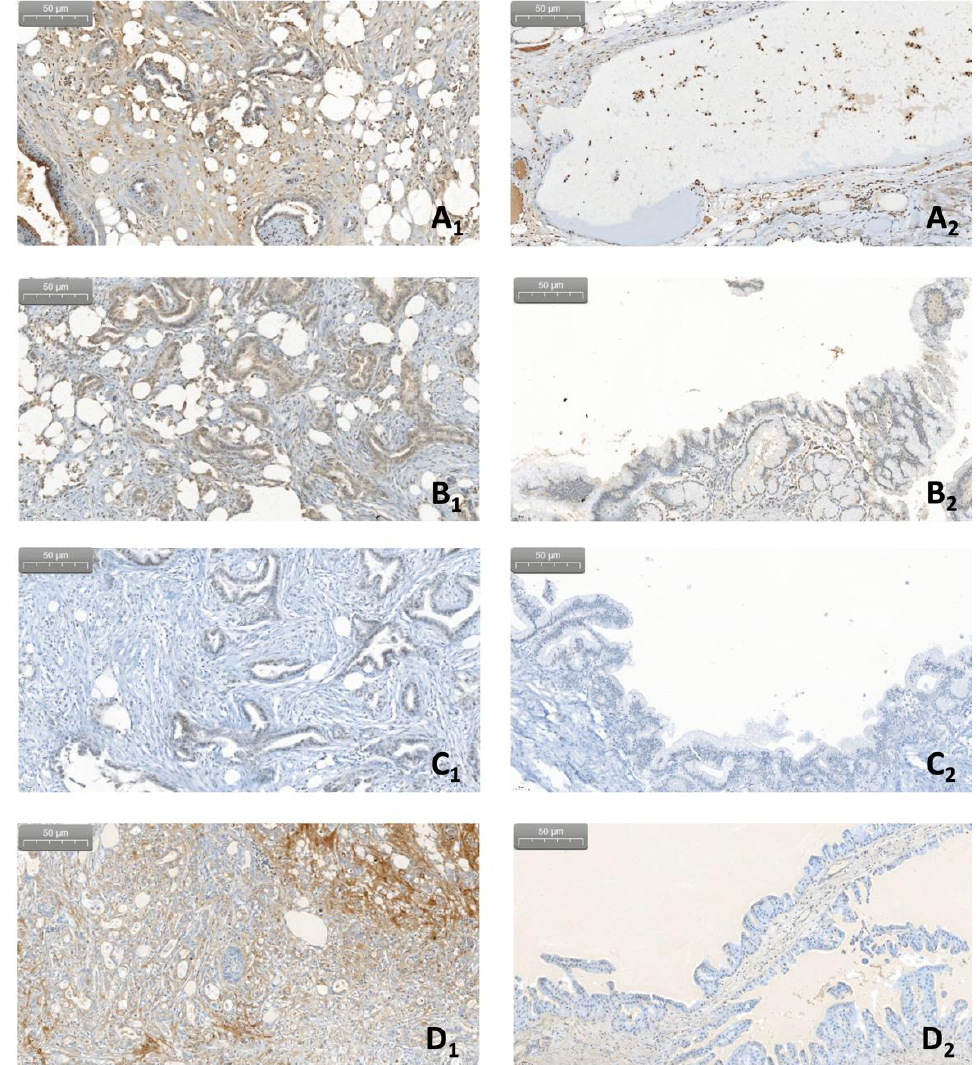
Figure 4. Immunohistochemistry. Comparison of the expression of complement factors between PDAC specimens (letters labelled with number 1) and specimens of benign or premalignant lesions (letters labelled with number 2: A 2 corresponding to serous cystic neoplasm, while B 2 , C 2 and D 2 depict intraductal papillary mucinous neoplasms, respectively). ( A ) expression of C1q; ( B ) expression of fB; ( C ) expression of MBL and ( D ) expression of C3c (magnification 20×).